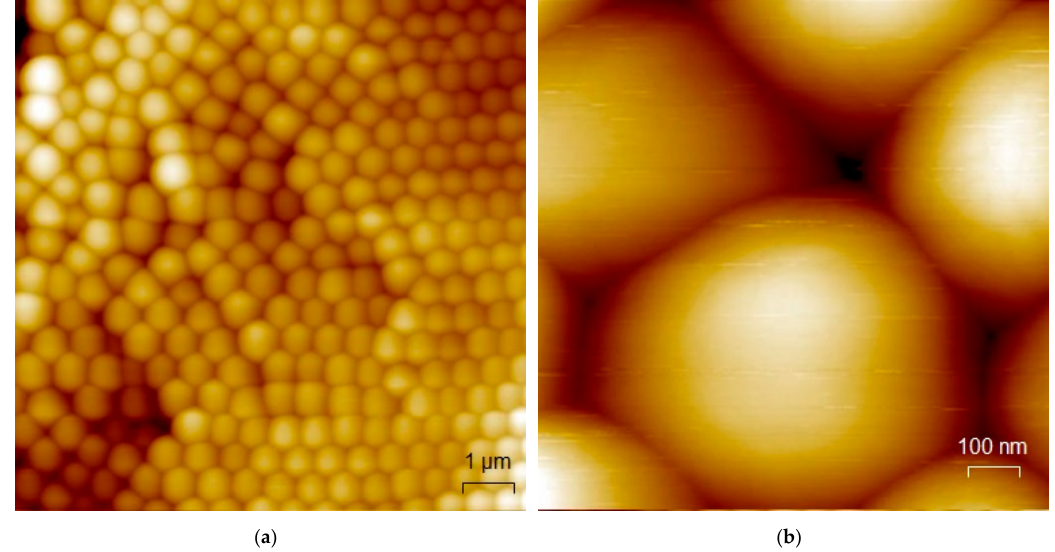
Figure 4. AFM images of the PS sphere coated pine wood sample on an area of 10 × 10 μ m² ( a ) and 1 × 1 μ m² ( b ).